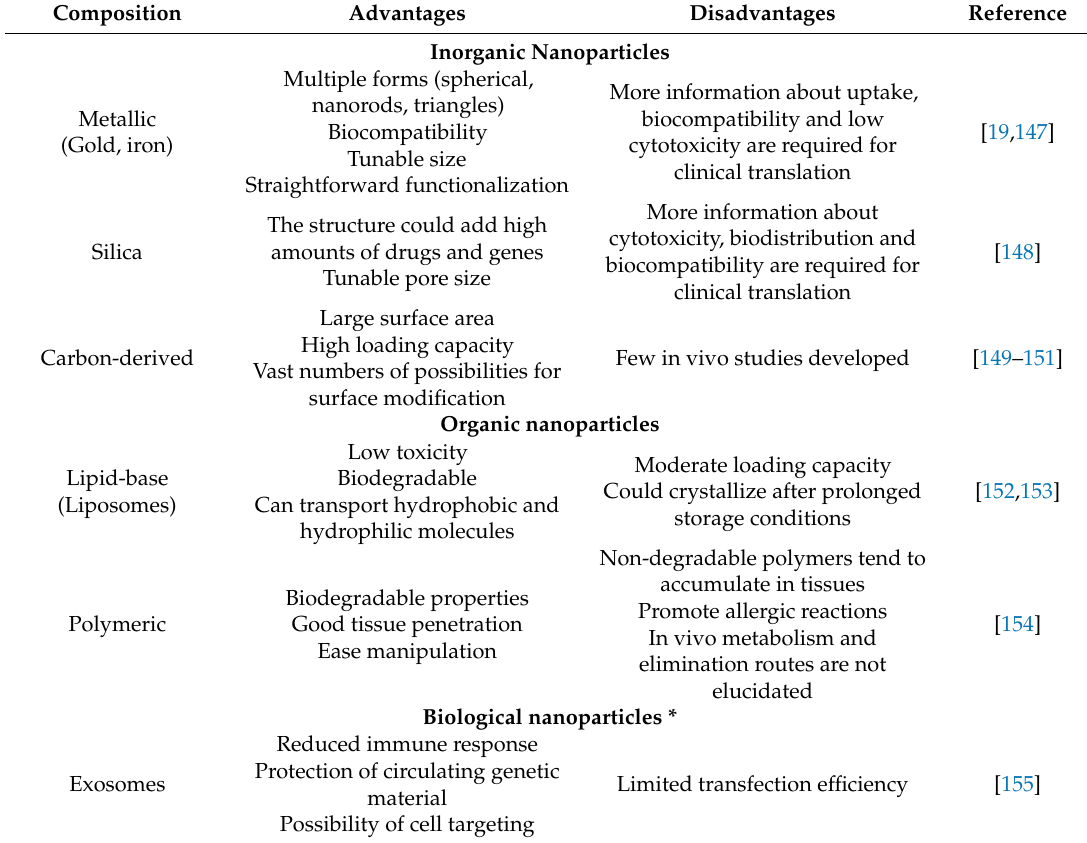
Table 1. Advantages and disadvantages of nanoparticles used for gene